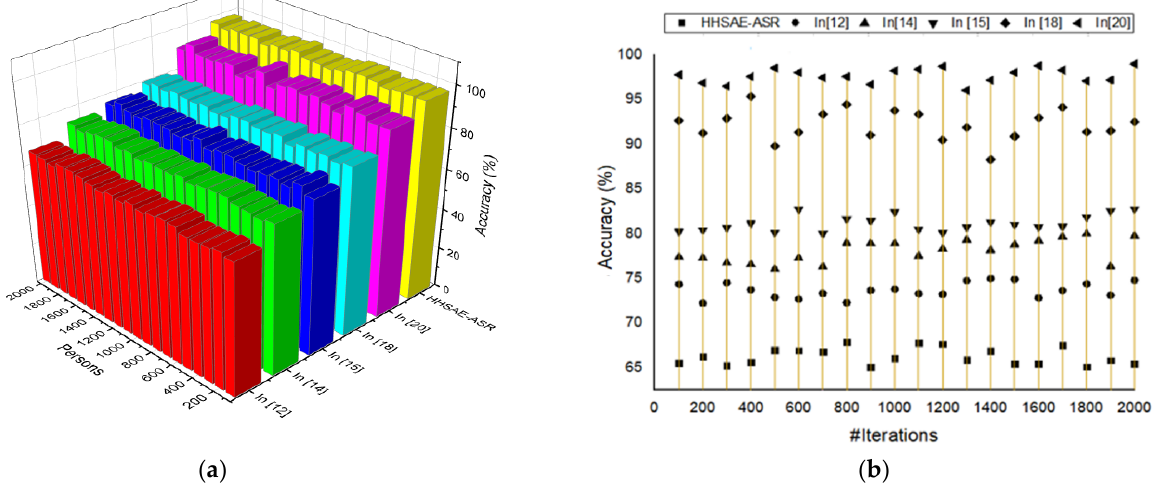
Figure 5. Training accuracy; ( a ) Training accuracy vs number of persons; ( b ) accuracy against number of iterations. of